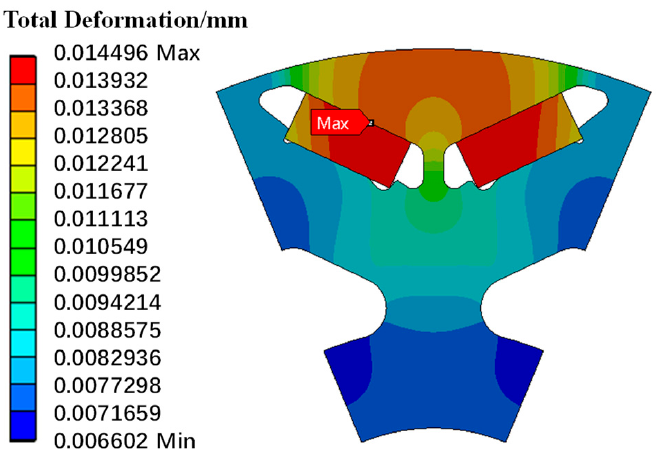
Figure 14. Rotor deformation under a structural field.